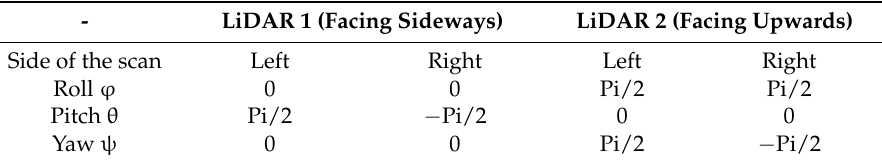
Table 2. Transformation and translation angles applied to the LiDAR